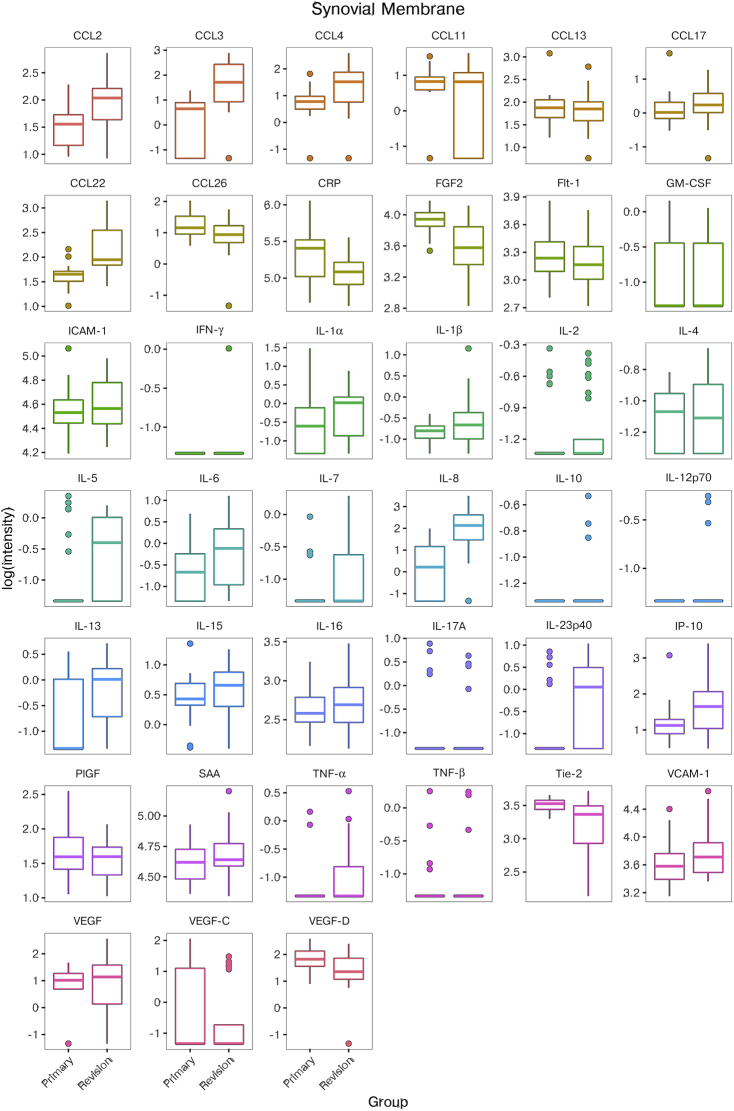
Protein expression profile of synovial membrane isolated from patients undergoing primary and revision total knee arthroplasty. Data are presented as box-and-whiskers plot. CRP, C-reactive protein; FGF, fibroblast growth factor; Flt, Fms-like tyrosine kinase 1; GM-CSF, granulocyte-macrophage colony-stimulating factor; ICAM, intercellular adhesion molecule; IFN, interferon; IP-10, interferon gamma-induced protein 10; PIGF, placental growth factor; SAA, serum amyloid A; Tie, tyrosine kinase; TNF, tumor necrosis factor; VCAM, vascular cell adhesion molecule; VEGF, vascular endothelial growth factor.